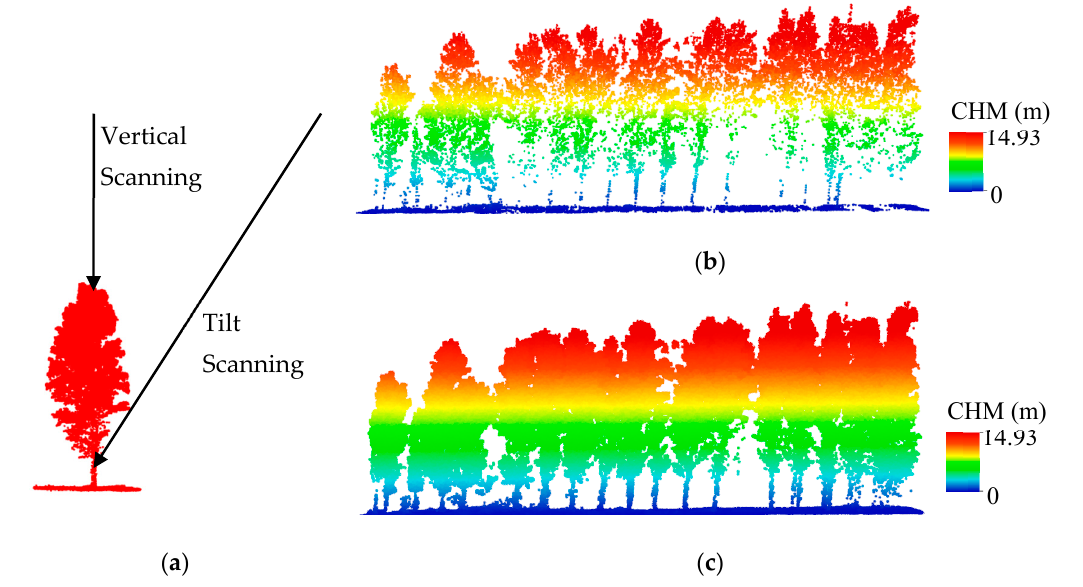
Figure 7. Point cloud data obtained from different scanning angles; ( a ) schematic diagram of vertical and tilt scanning; ( b ) point cloud profile of vertical scanning; ( c ) point cloud profile of tilt scanning.